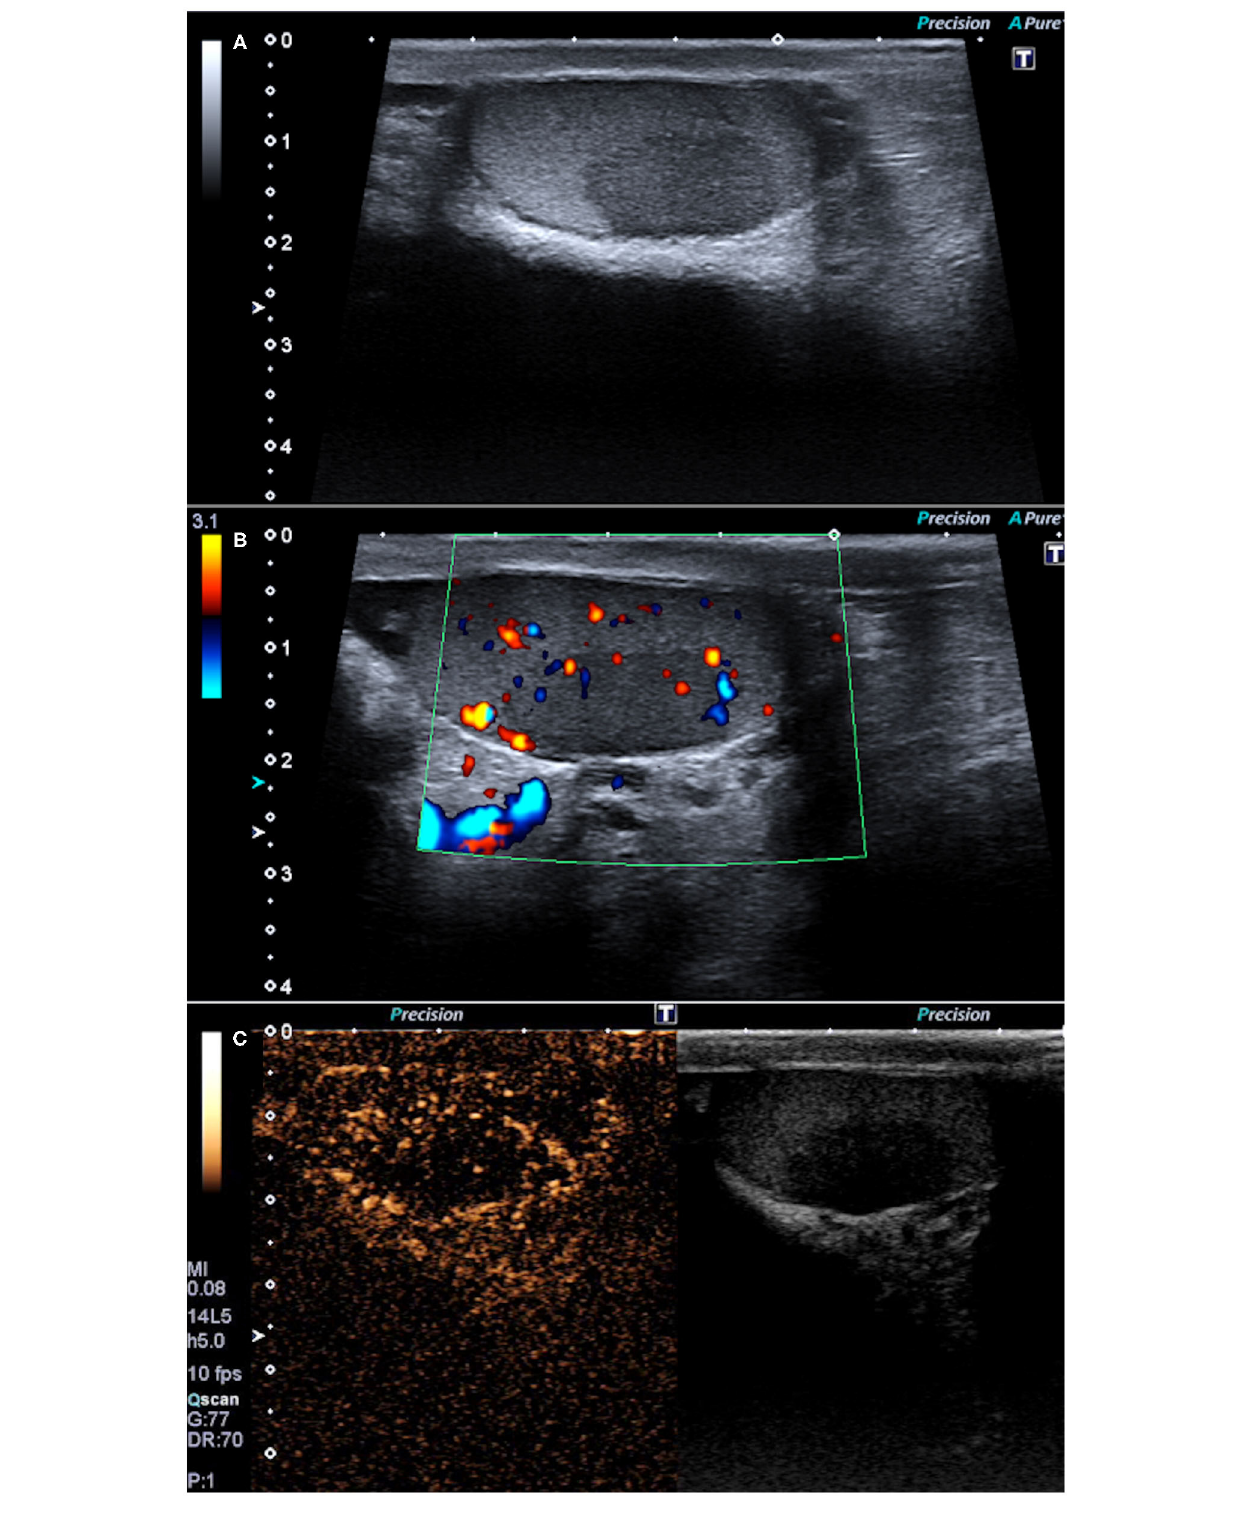
FIGURE 2 | B-mode ultrasonography showing one hypoechoic lesion in the left testis with ill-defined margins (A) and some Color-Doppler flow (B) . Contrast-enhanced ultrasonography showing the hypovascular appearance of the lesions as compared to the surrounding testicular tissue (C) .